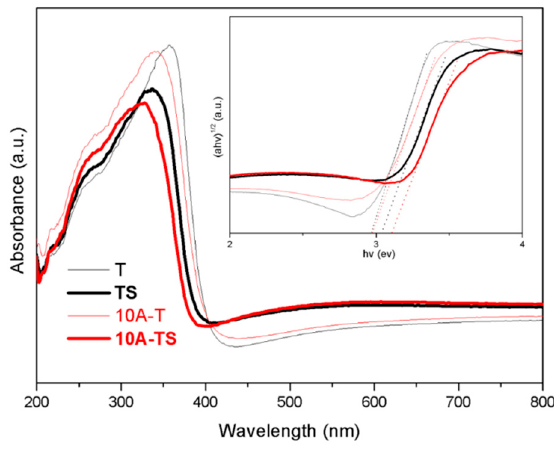
Figure 7. UV–Vis absorption spectra of the TiO 2 photocatalysts (T and 10A-T) and TiO 2 / sericite photocatalysts (TS and 10A-TS).